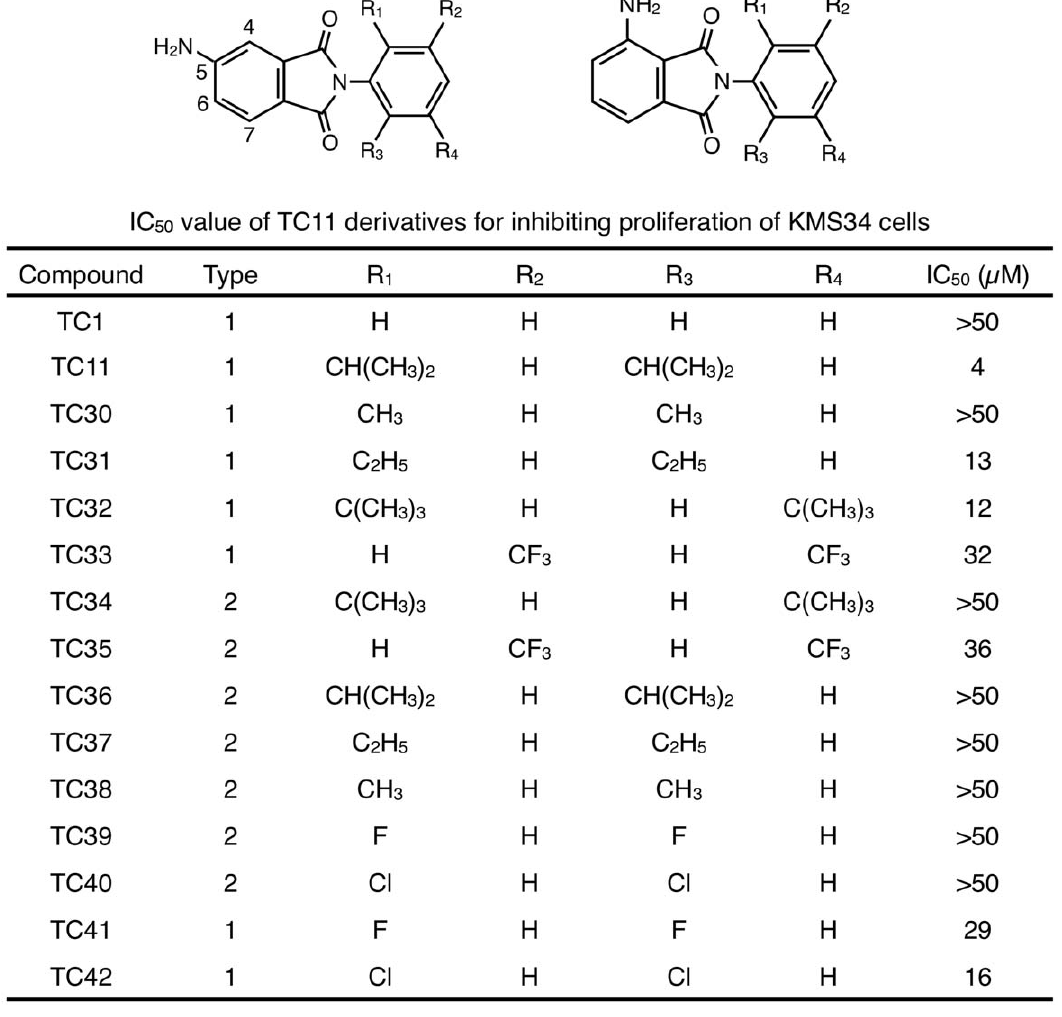
Figure 1. IC 50 values of TC11 derivatives for inhibiting proliferation of KMS34 cells. KMS34 cells (1 6 10 4 cells/well) in 96-well plate were incubated with 0–50 m M of indicated compound for 72 h. Then cell viability was determined with WST-1 assay.